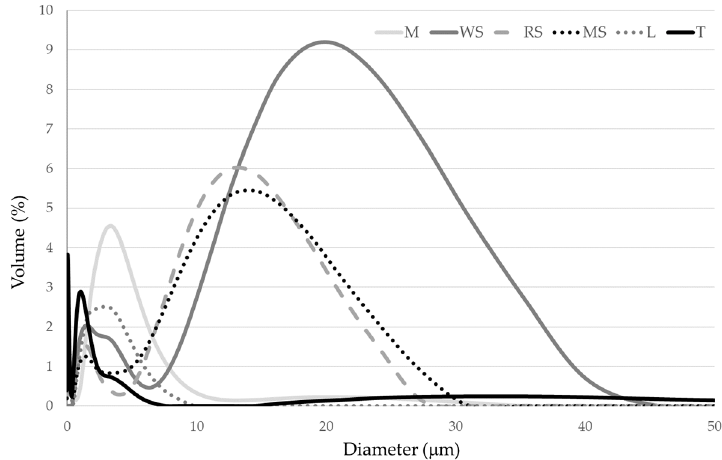
Figure 2. Particle size distribution of emulsions prepared with pumpkin oil and carbohydrate materials: maltodextrin (M), wheat starch (WS), rice starch (RS), maize starch (MS), lactose (L) and trehalose (T).